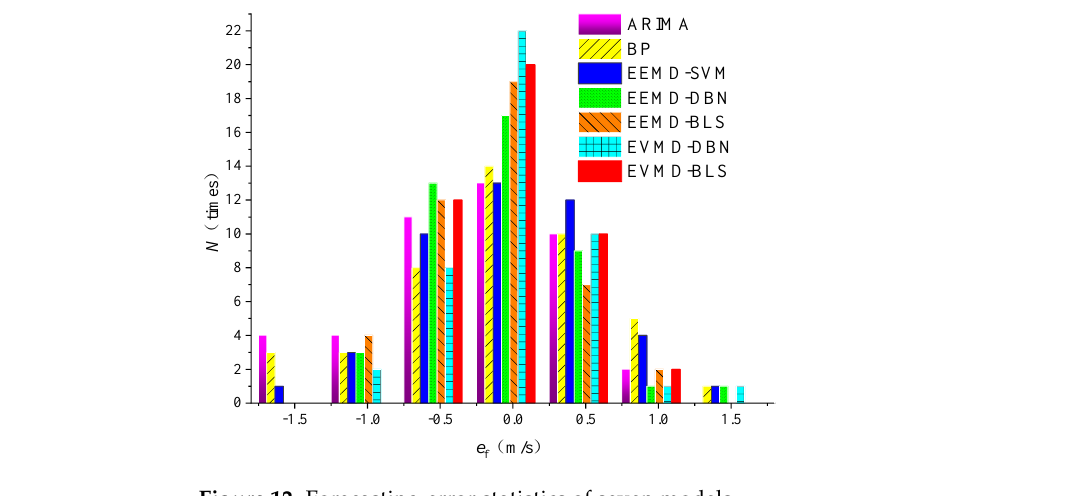
Figure 12. Forecasting-error statistics of seven models. Table 3. Evaluation result of forecasting